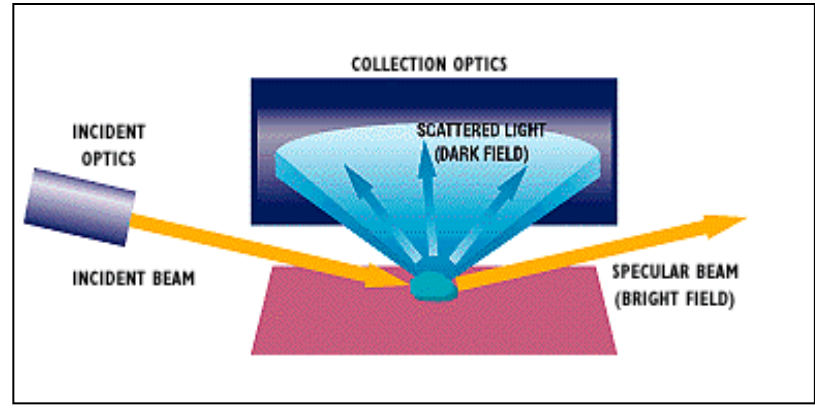
Figure 4. Basic principle of light scattering used in optical inspection. Incident beam from the left yields the specular beam (bright field) to the right.